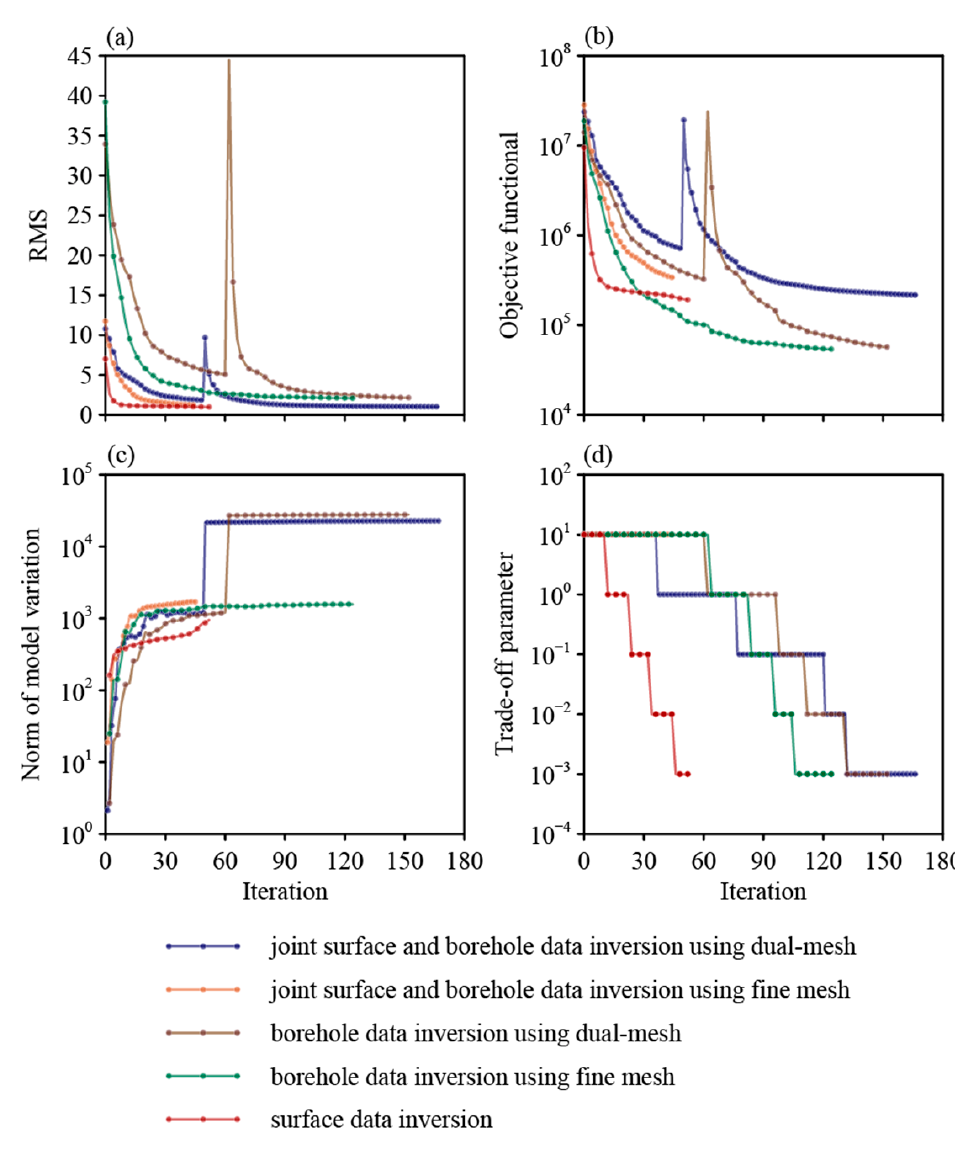
Figure 4. Inversion parameters versus iterations for the model in Figure 3. ( a ) RMS; ( b ) Objective functional; ( c ) Model; ( d ) Trade-off parameter.